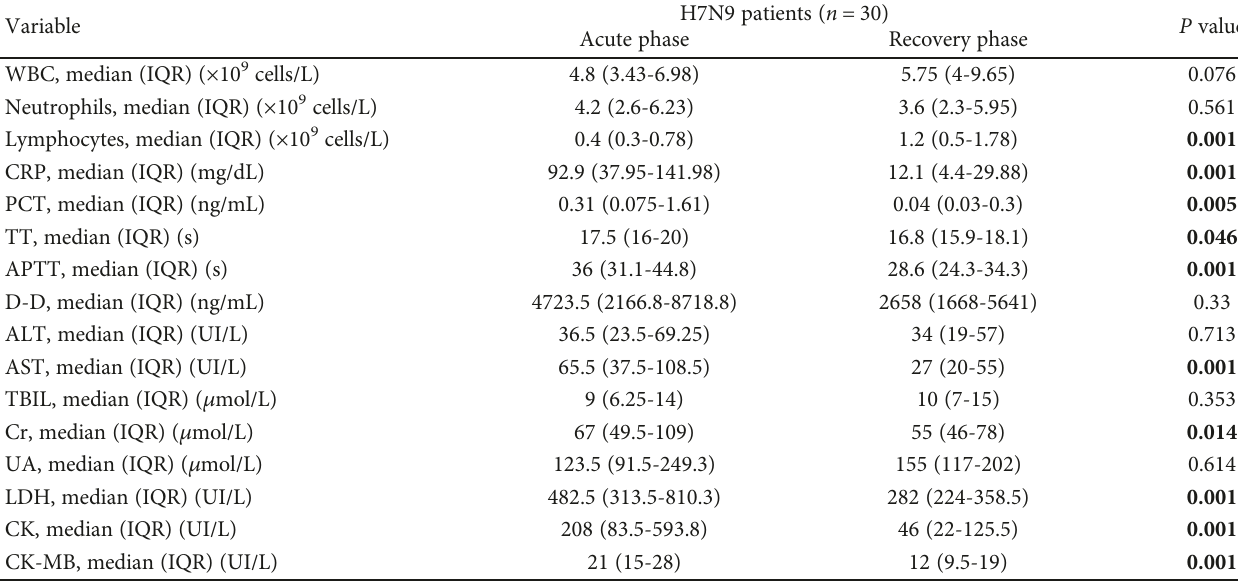
Table 2: Laboratory results for patients with avian in fl uenza A (H7N9) virus